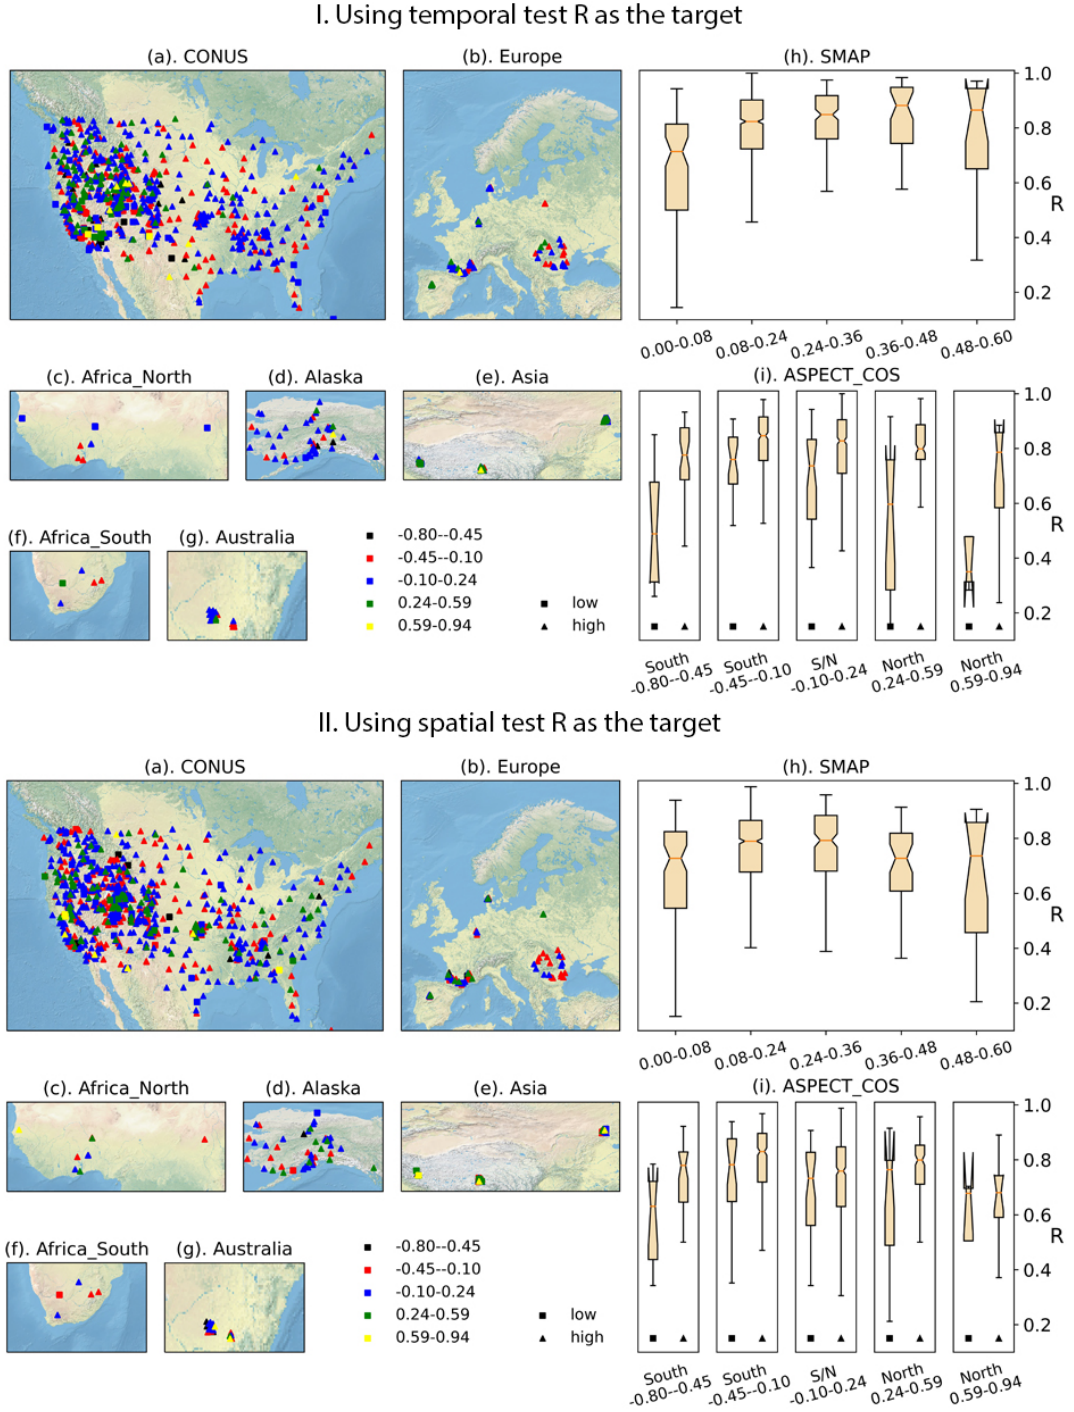
Figure 6. Stratified analysis of the distribution of R values from (I) temporal and (II) spatial tests. (a–g) The maps show the global distribution of test sites as a function of average SMAP soil moisture value and aspect. The colors on the map represent aspect cosine. The average SMAP < 0 . 08 sites are a minority class and are represented by squares. (h) The SMAP boxplot shows the distribution of R under different average soil moisture values (SMAP). (i) The aspect boxplot shows the distribution of R in different aspect cosine bins, where the left boxplot in each bin indicates SMAP (cid:53) 0 . 08, and the right boxplot in each bin indicates SMAP > 0 . 08. The upper half of the figure, part I, shows temporal test R values (which characterize temporal nonstationarity), while the lower half of the figure, part II, shows spatial test R values, which characterize the effect of spatial heterogeneity. Maps are made with Natural Earth imagery, no permission needed (Natural Earth,